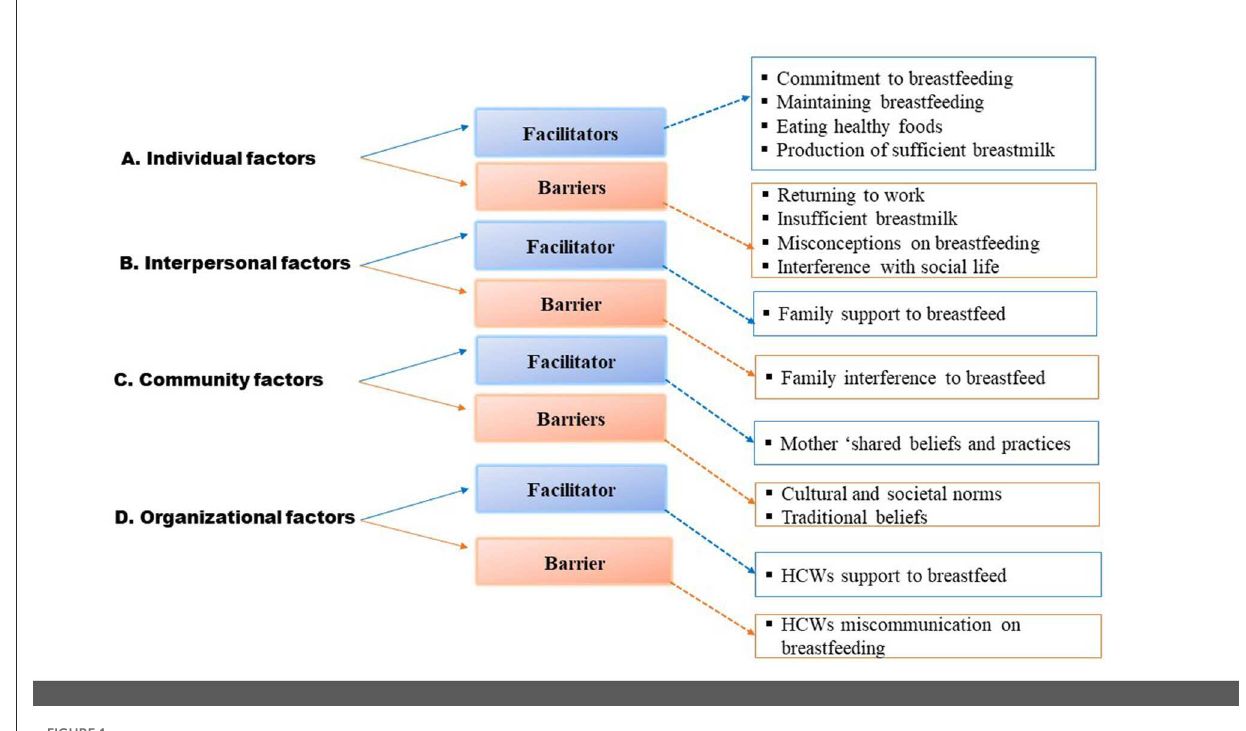
FIGURE1 Emergent themes from IDIs and FGDs.